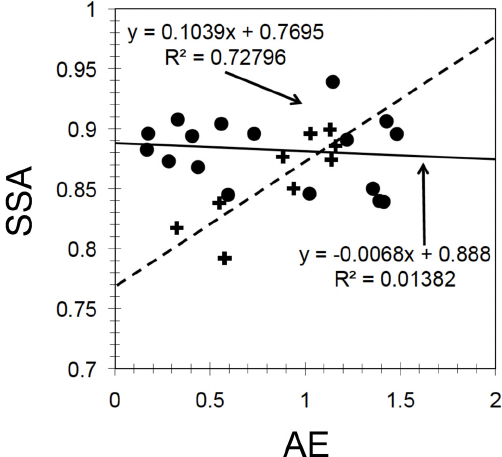
Fig. 8. Scatter plot of AE vs SSA over Hyderabad in 2008. Black circles indicate simulations both with the AC and the modified emis- sions and crosses indicate observations. The lines are best fits to the data points (thick line: black circles, dashed line: crosses).